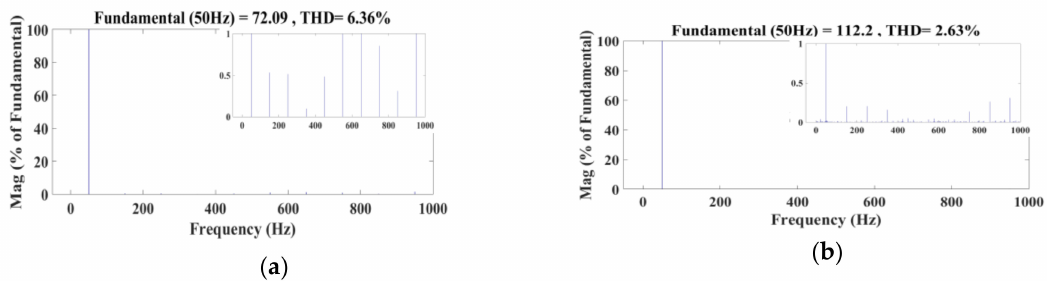
Figure 16. THD in output Voltage; ( a ) symmetric, ( b )